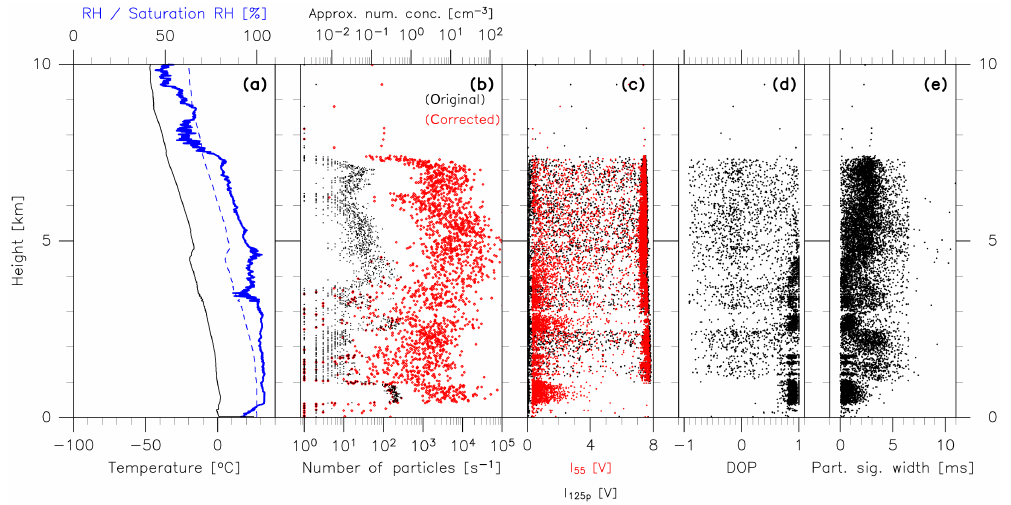
Figure 6. Results from a CPS flight at Moriya, Japan, launched at 17:30LT on 21 January 2015. Vertical profiles are shown of (a) temperature (black), RH (blue solid), and ice saturation RH (dashed blue) from the RS-11G radiosonde; (b) number of particles counted per second (and number concentration assuming 5ms − 1 flow speed), original in black and corrected (see Sects. 2.3 and 3.1) in red; (c) particle output voltages I 55 (red) and I 125p (black); (d) the degree of polarization (DOP) (not calculated when I 55 is greater than 7V; see Sect. 3.1); and (e) particle signal width in